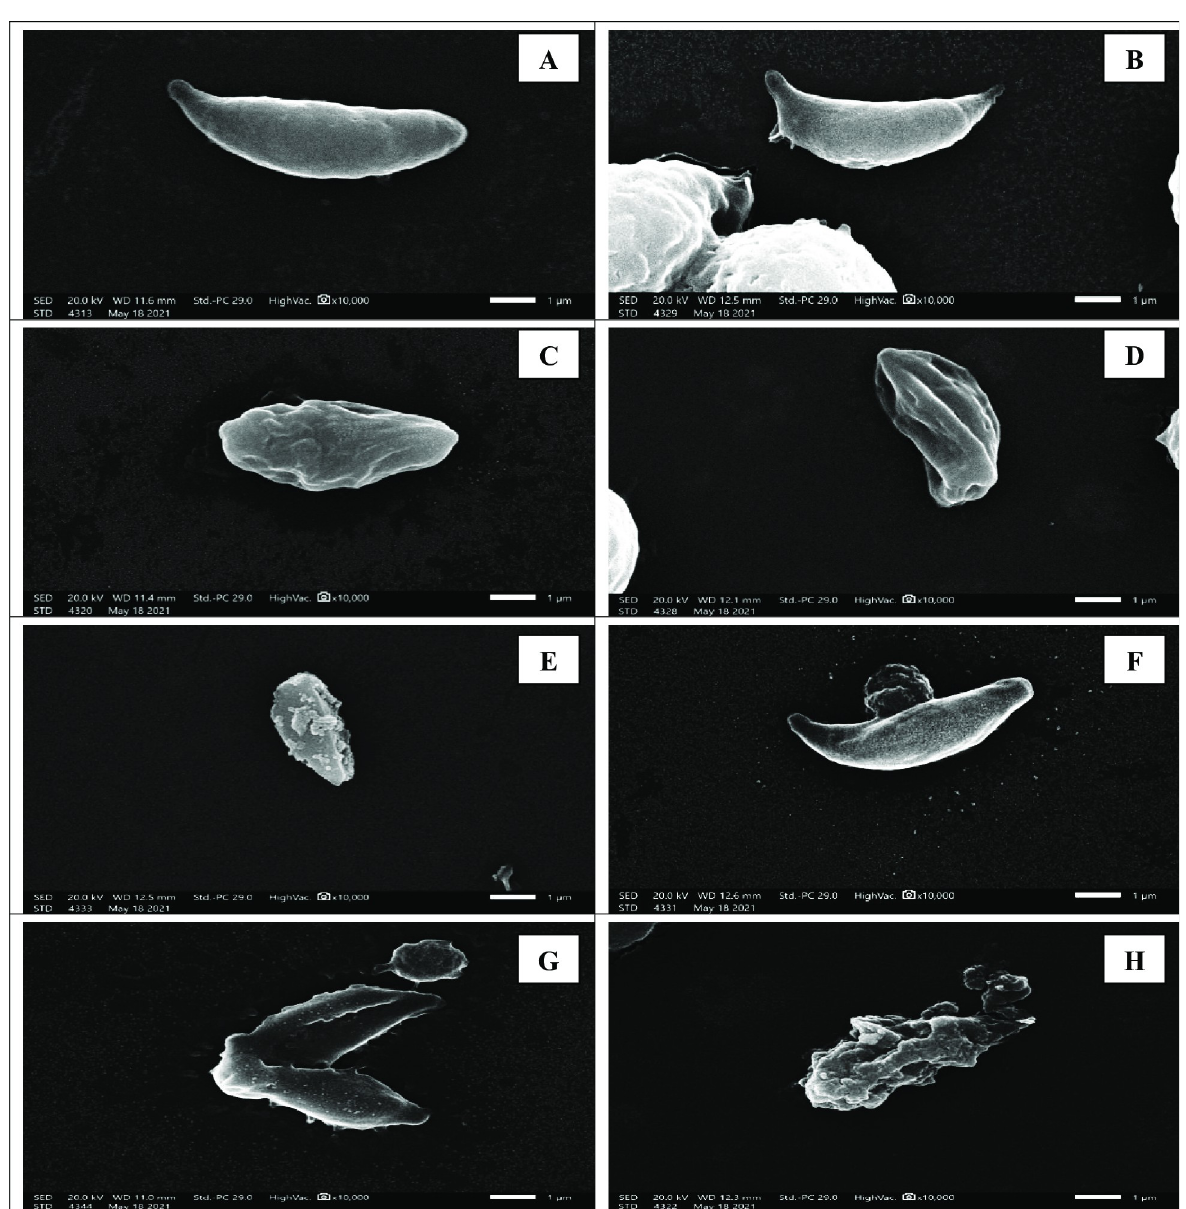
Fig 7. SEM of Toxoplasma tachyzoites. (A) Tachyzoite from subgroup I b (infected untreated control), revealing crescent shape with apparent conoid (X 10,000). (B) Tachyzoite from subgroup II a, showing evident loss of its smooth surface with erosion and protrusion of the surface. (X 10,000). (C) Tachyzoite from subgroup II b, showing shrunken organism losing its crescent shape, smooth surface, conoid and tapered ends with profound furrows and ridges (X 10,000). (D) Tachyzoite from subgroup II c, showing a shrunken distorted parasite losing the crescent shape, tapered ends and conoid with noticeable surface erosion and ulceration (X 10,000). (E) Tachyzoites from subgroup II d, showing loss in the crescent shape, smooth surface, conoid and tapered ends with multiple blebs on the parasite surface (X 10,000). (F) Tachyzoites from subgroup II e, showing a rupturing parasite losing its smooth surface (X 10,000). (G) and (H) Tachyzoites from subgroup II f, showing disfigured rupturing organism losing its conoid with disorganised lacerated surface (X 10,000). the mean survival time was reported in all treated groups. Mice treated with spiramycin/prop- olis loaded CS/Alg NPs exhibited the longest mean survival time up to 19 days post-infection with no mortality at the day of sacrifice. In agreement with our results, other studies reported a